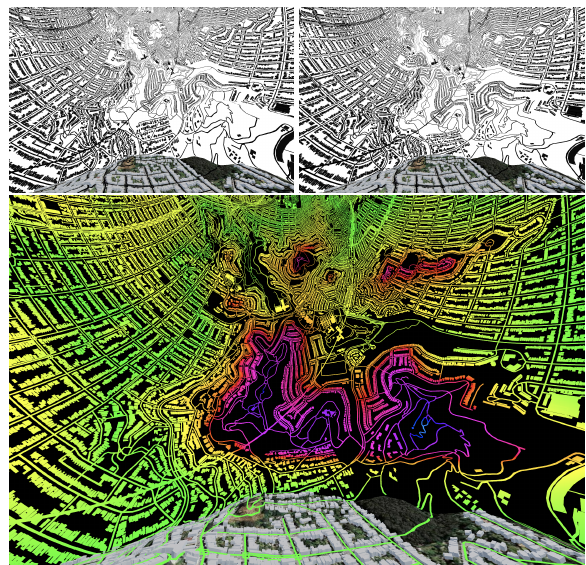
Figure 3. Projecting a terrain ( upper left ), its flattened version ( upper right ), and the differences between the two versions (lower); green for no change, purple for strong